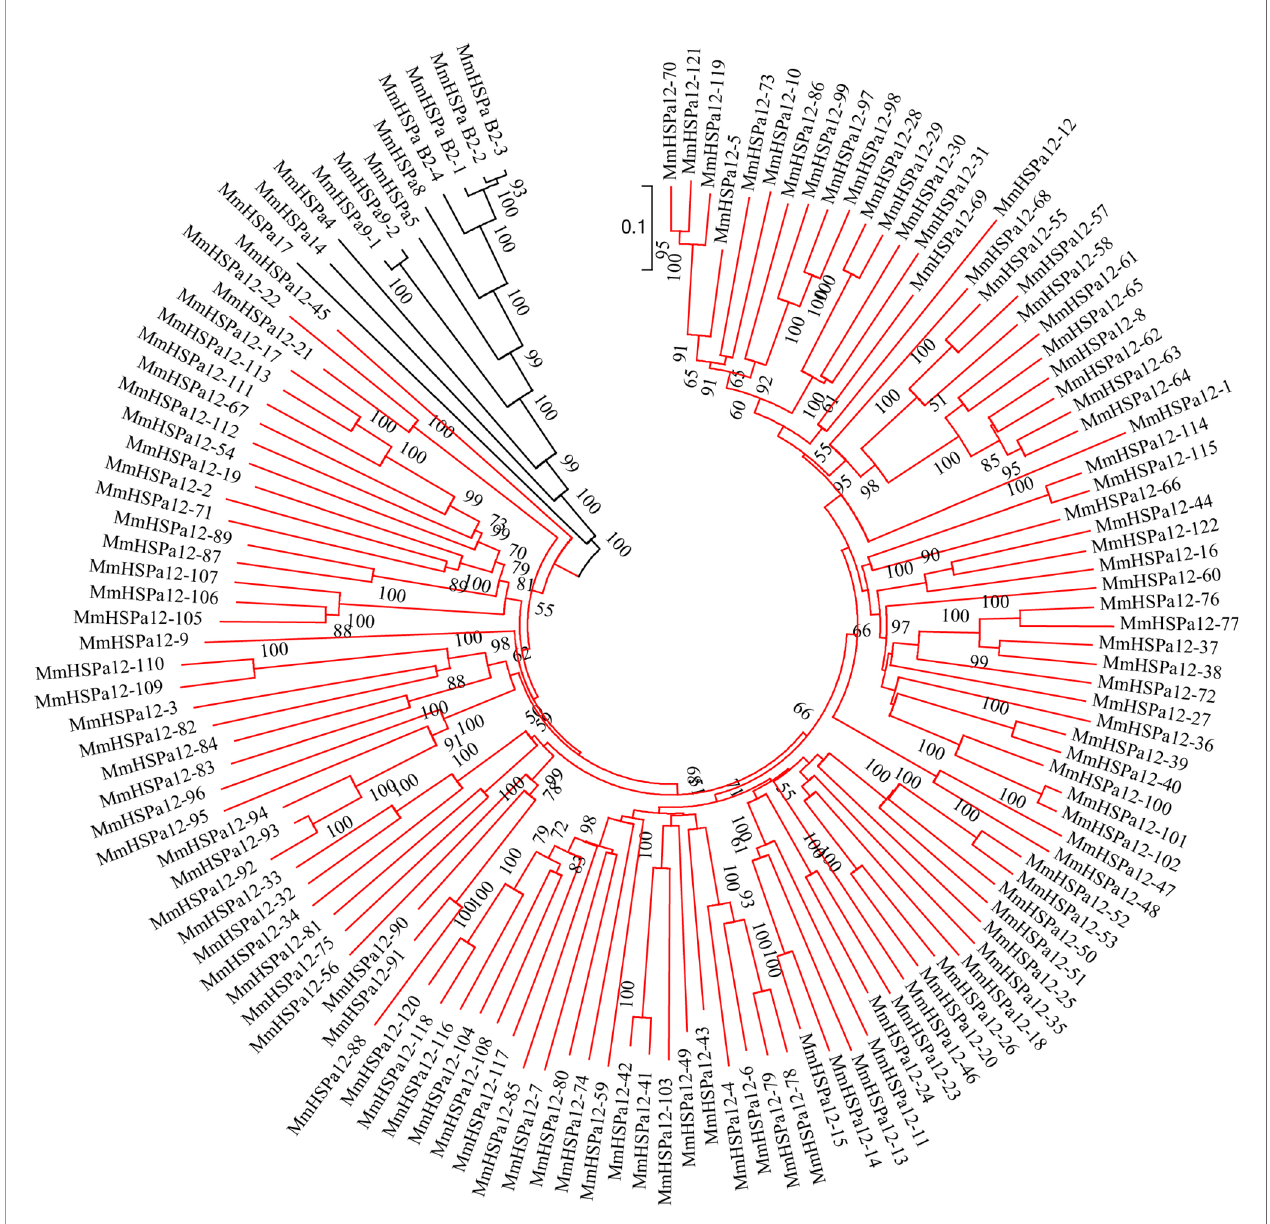
FIGURE 4 | Phylogenetic analysis of 133 M. mercenaria HSP70 protein sequences. The phylogenetic tree was created with MEGA 7.0 software using the Neighbor- Joining method. The HSPa12s were highlight in red. Support value was assessed using bootstrapping (100 pseudoreplicates), if value was less than 50, the data was not